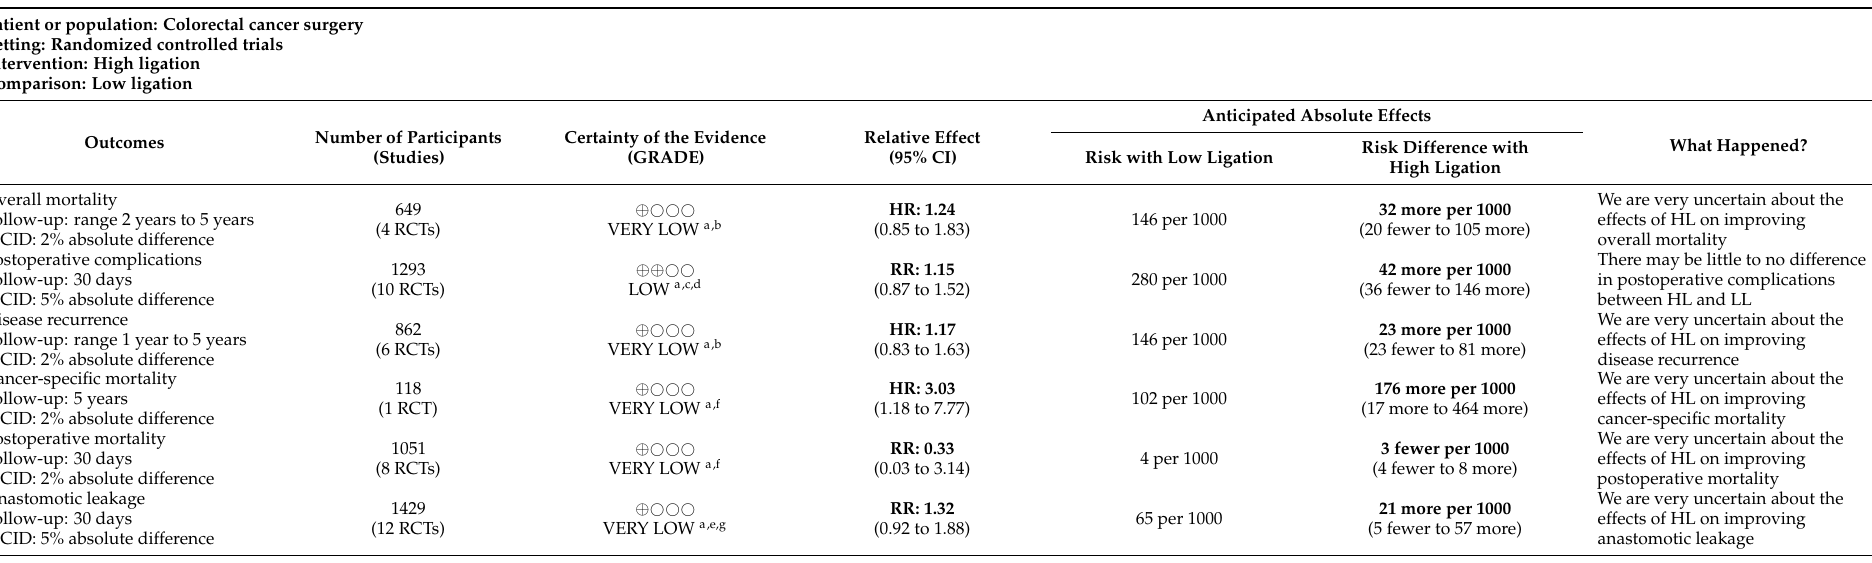
Table 2. Summary of findings: high ligation compared with low ligation in colorectal cancer surgery (primary and secondary outcomes, except for functional outcomes). Patient or population: Colorectal cancer surgery Setting: Randomized controlled